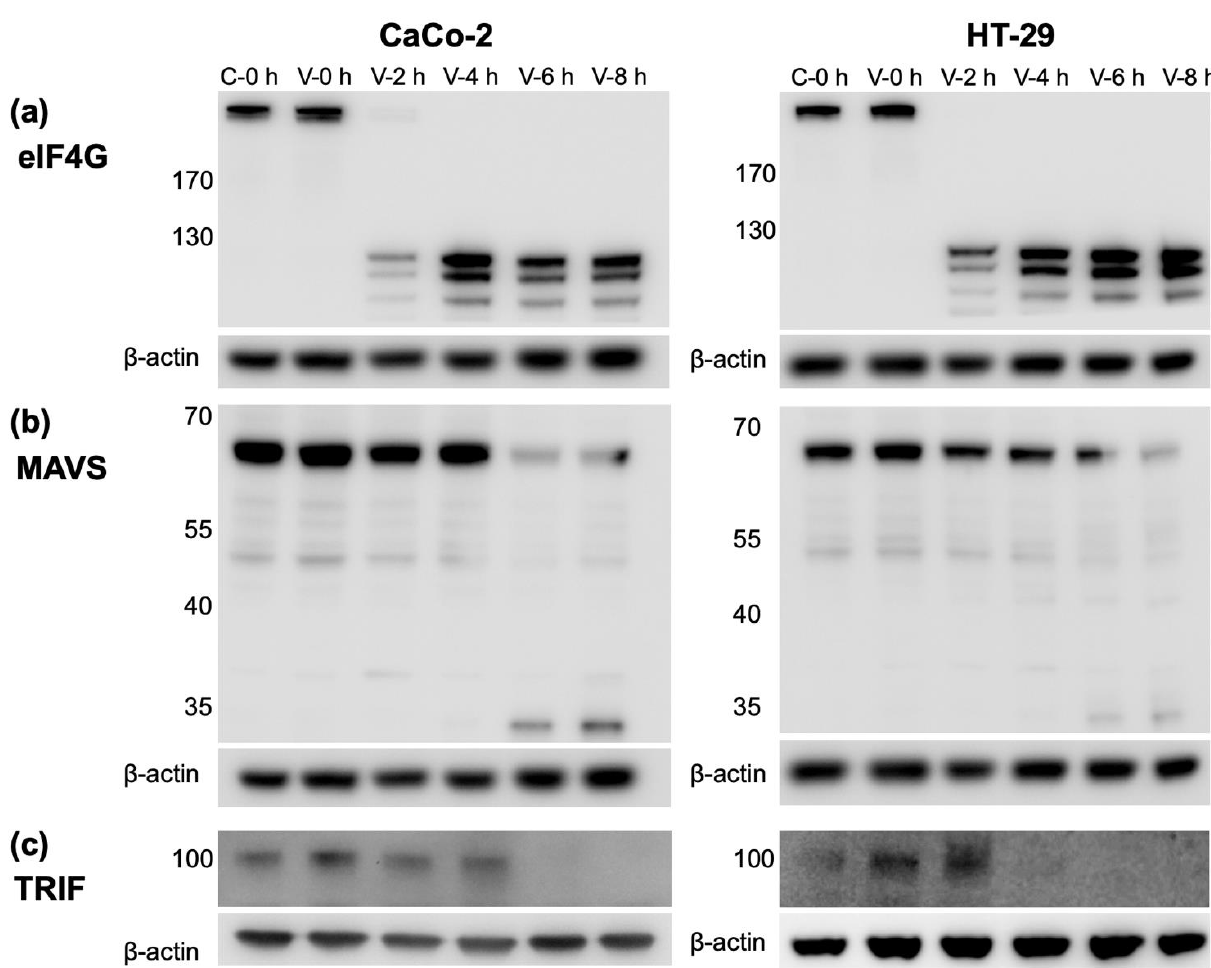
Figure 5. Coxsackievirus B3 (CVB3) interferes with proteins involved IFN production. ( a – c ) Intestinal epithelial cells were mock infected (C-0 h) or infected with CVB3 (multiplicity of infection, MOI=1; V-0 h – V-8 h) and protein was extracted at 0, 2, 4, 6, and 8 h p.i. The presence of eukaryotic initiation factor 4G (eIF4G; a ), mitochondrial antiviral signaling protein (MAVS; b ) and TIR-domain-containing adaptor-inducing interferon-β (TRIF; c ) were detected by Western blot and β-actin was used as a loading control. Representative images from a minimum of two experiments with similar results.